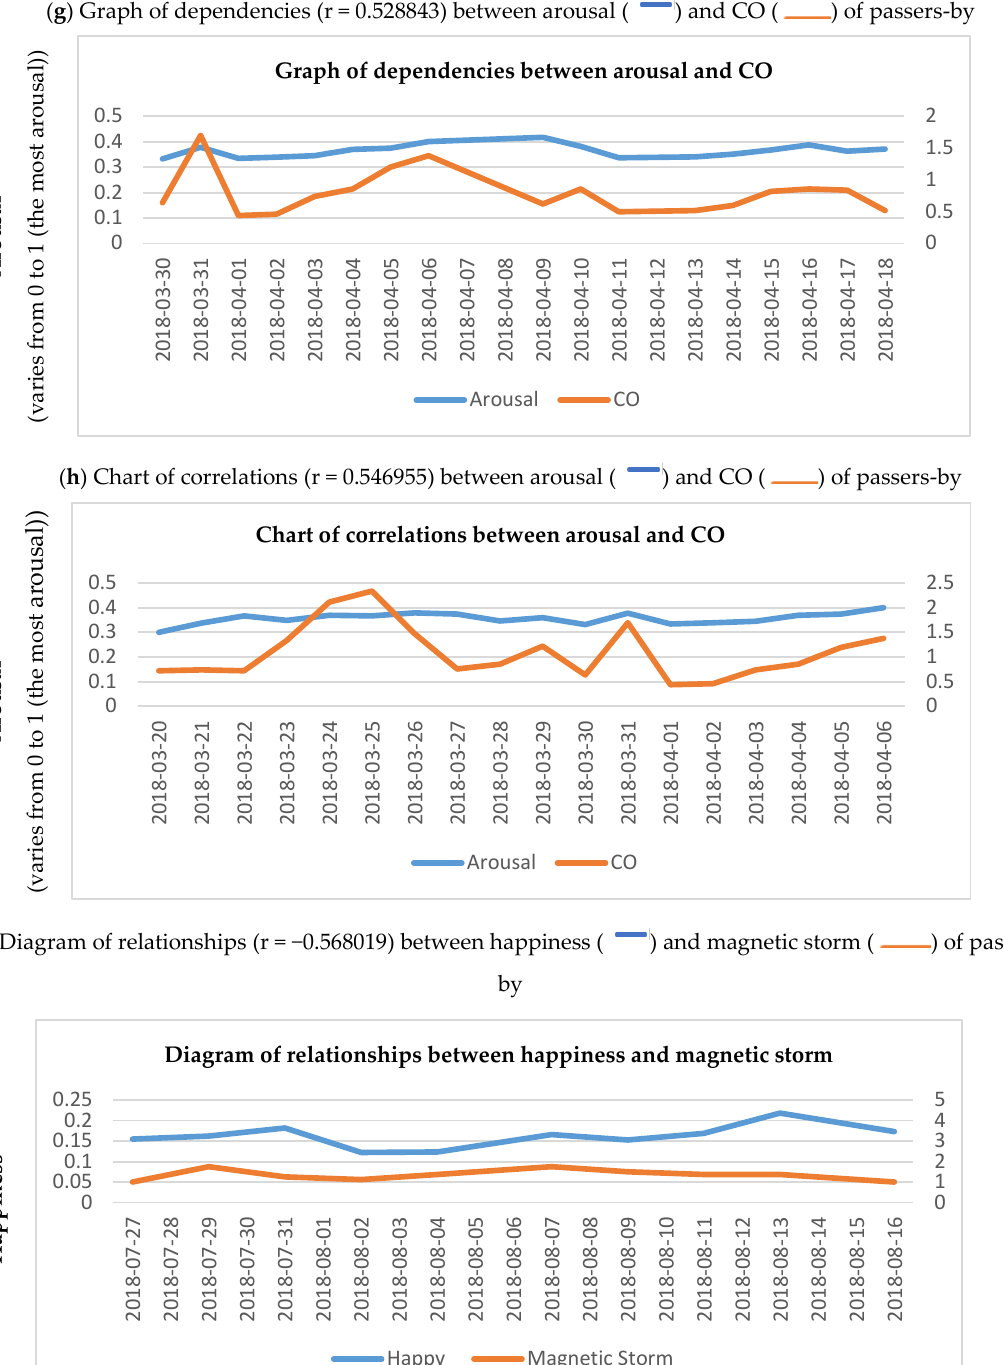
Happy Magnetic Storm Figure 3. Cont